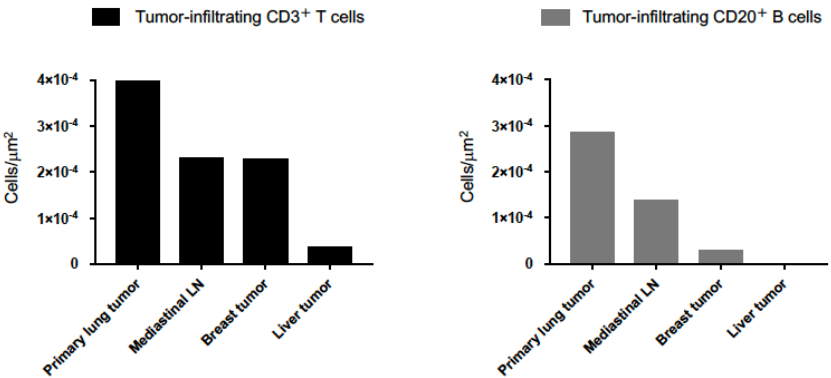
Figure 5. Quantification analysis of tumor-infiltrating CD3 + T cells and CD20 + B cells. High-speed scanning of whole slide images was performed on stained tissue sections. Images of full sections were acquired and analyzed with automated quantitative pathology imaging system. All images were analyzed and statistics of the number of tumor-infiltrating CD3 + T cells and CD20 + B cells was generated automatically. The number of tumor-infiltrating CD3 + T cells and CD20 + B cells was decreased with the distance from primary lung lesion.